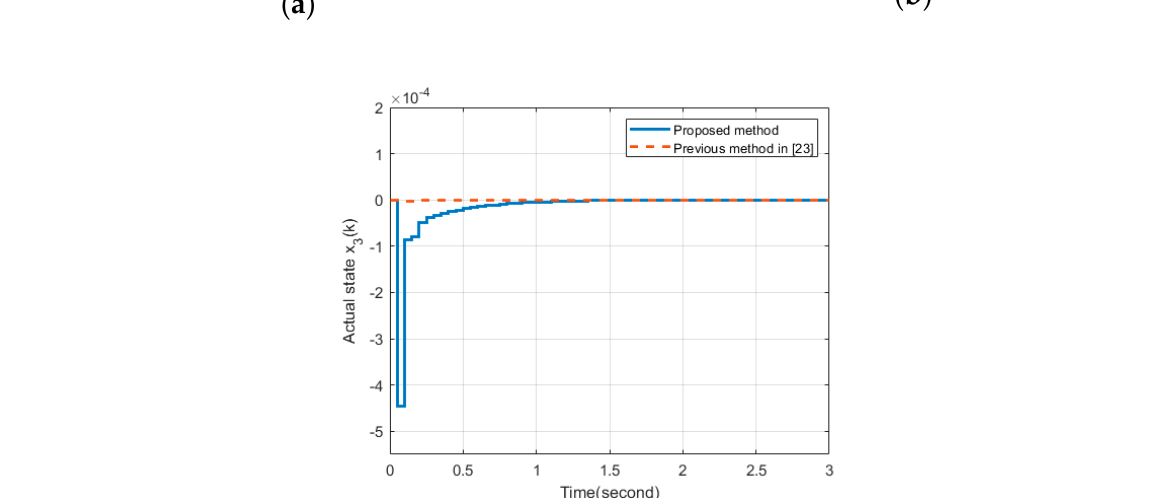
( ) x k ; ( b ) The comparisons of 1